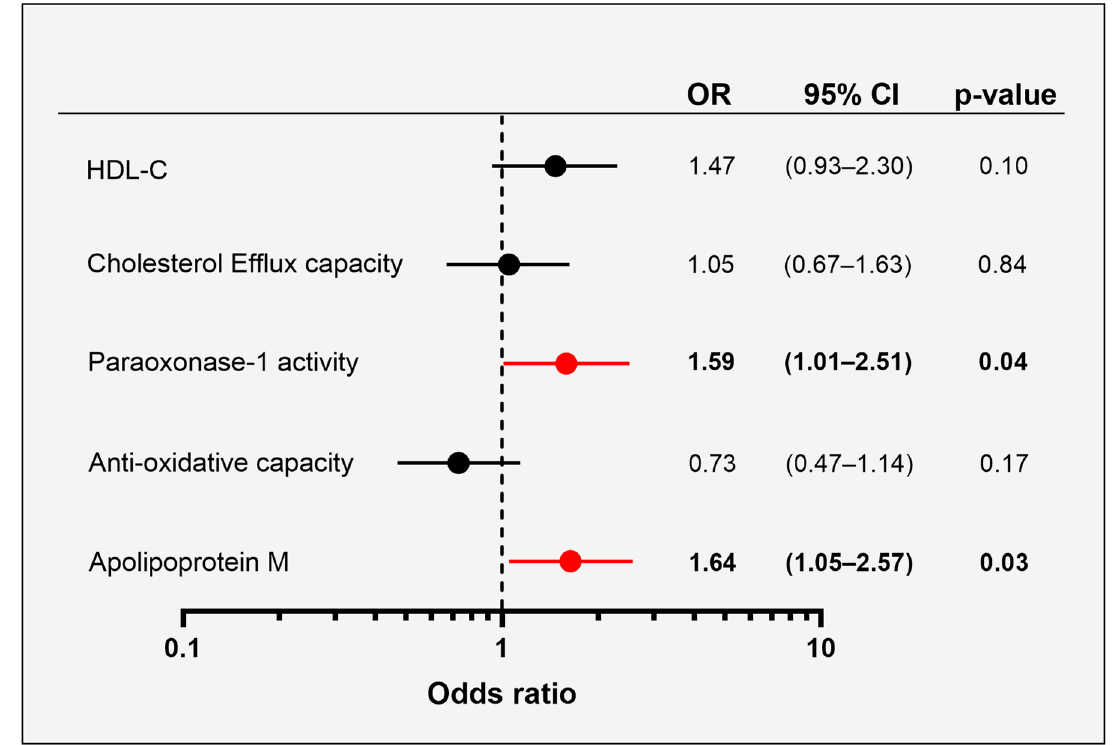
Figure 3. Forest plot with logistic regression analyses showing associations between HDL-related parameters (z-scores) at <20 weeks’ gestation and the risk of developing GHTN in the second and third trimester of pregnancy. Odds ratio per 1 SD increase of the variables. Models were adjusted for maternal age, BMI and HOMA-R. Significant results are highlighted in red.